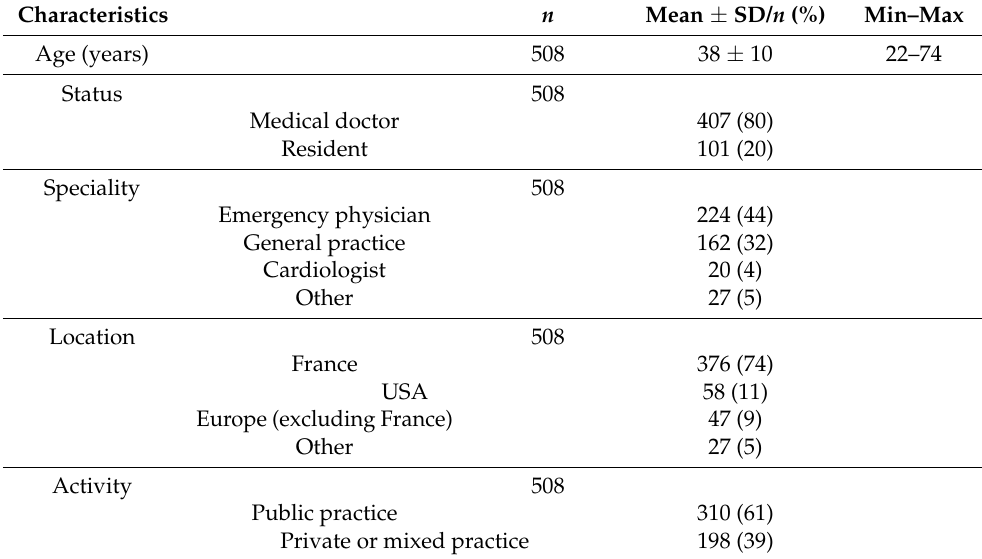
Table 1. Characteristics of the participating physicians.